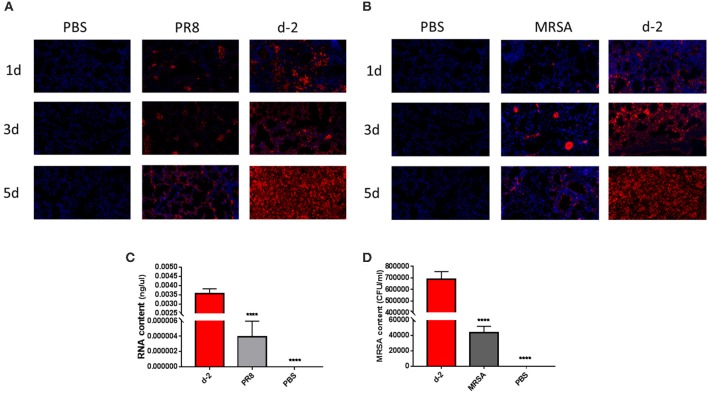
Over-proliferation of pulmonary pathogens in coinfected mice in group d-2. (A) PR8 in the lungs of group d-2 mice showed significant proliferation between day 1 and day 5 after coinfection compared to the control PR8 group and the group infected with a non-lethal dose of PR8 alone. (B) MRSA in the lungs of group d-2 mice showed significant proliferation between day 1 and day 5 after coinfection compared with the control PR8 group and the group infected with a non-lethal dose of MRSA alone. (C) Real-time fluorescence quantitative PCR was used to detect the mRNA levels of PR8 in lung homogenates from group d-2 mice acquired on the fifth day of coinfection. Compared with the control PBS group and the group infected with a non-lethal dose of PR8 alone, mRNA levels in group d-2 far exceeded those in the control groups (****p < 0.0001, n = 6). (D) Lung homogenate from mice in the d-2 group was obtained on the fifth day post-coinfection, and bacterial culture was performed. Compared with the control PBS group and the group infected with a non-lethal dose of PR8 alone, the MRSA bacterial load in the lungs of group d-2 mice far exceeded those of the control groups (****p < 0.0001, n = 6). PR8, influenza A virus strain; MRSA, methicillin-resistant S. aureus; PBS, phosphate-buffered saline.